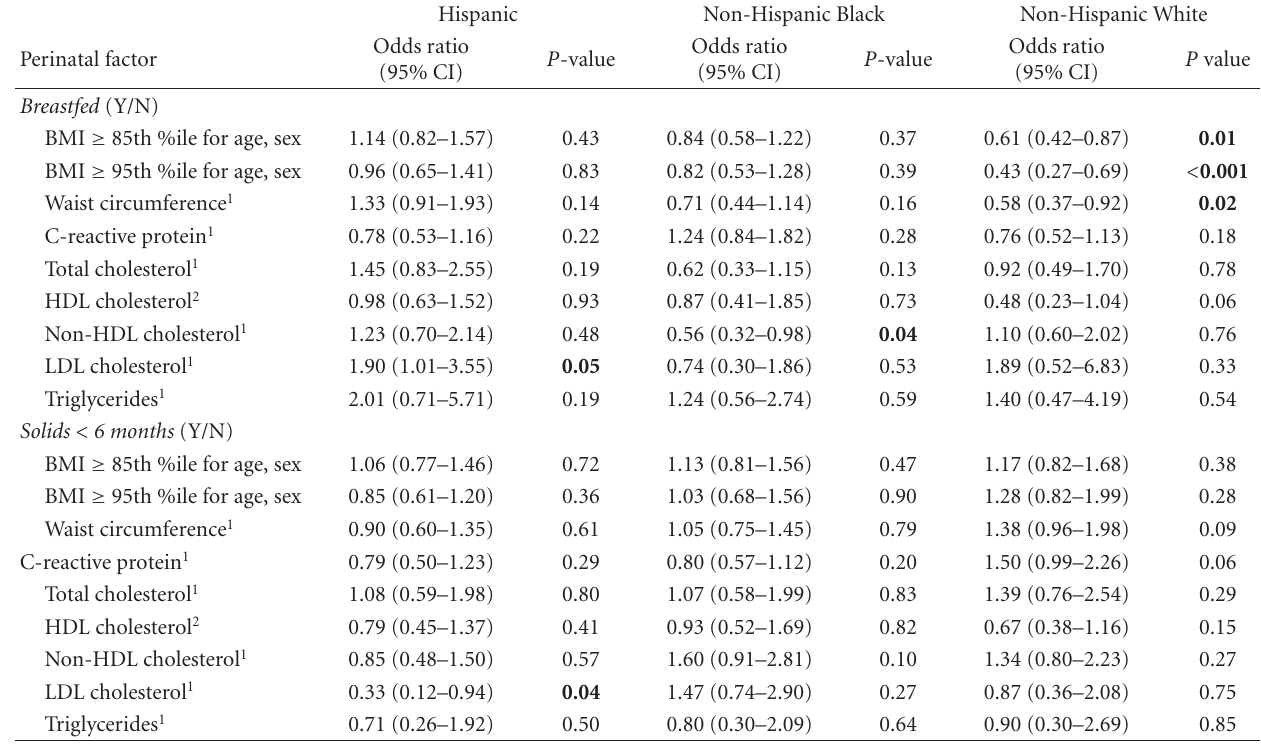
Table 4: Elevated cardiovascular disease risk factors among US 3-to-6-year-olds by ethnicity and infant nutrition practices, National Health and Nutrition Examination Survey, 1999–2008.